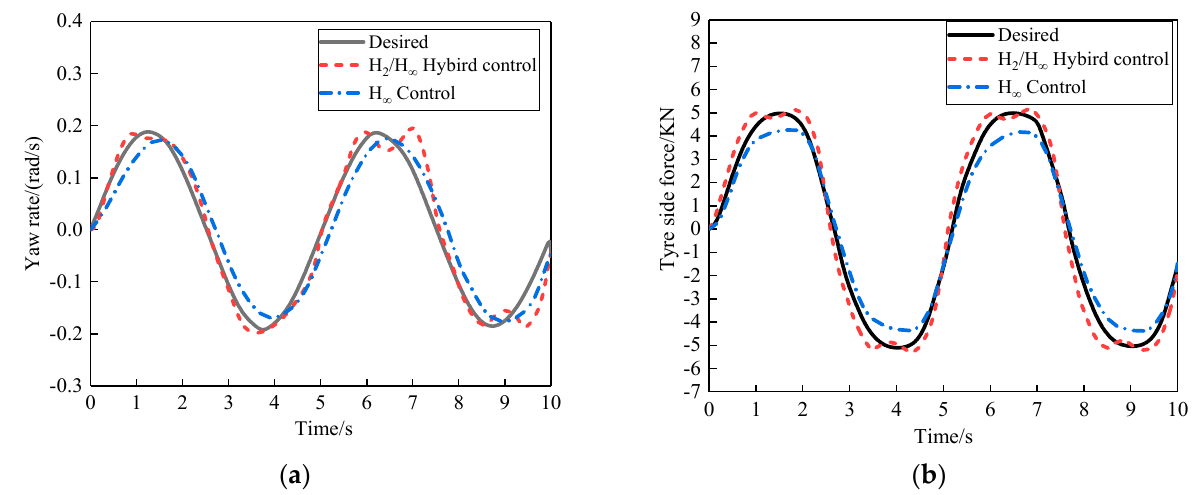
Figure 10. Sine input HIL simulation verification (when V x is 20 m/s, and μ is 0.4). ( a ) Yaw rate; ( b ) tire side force.